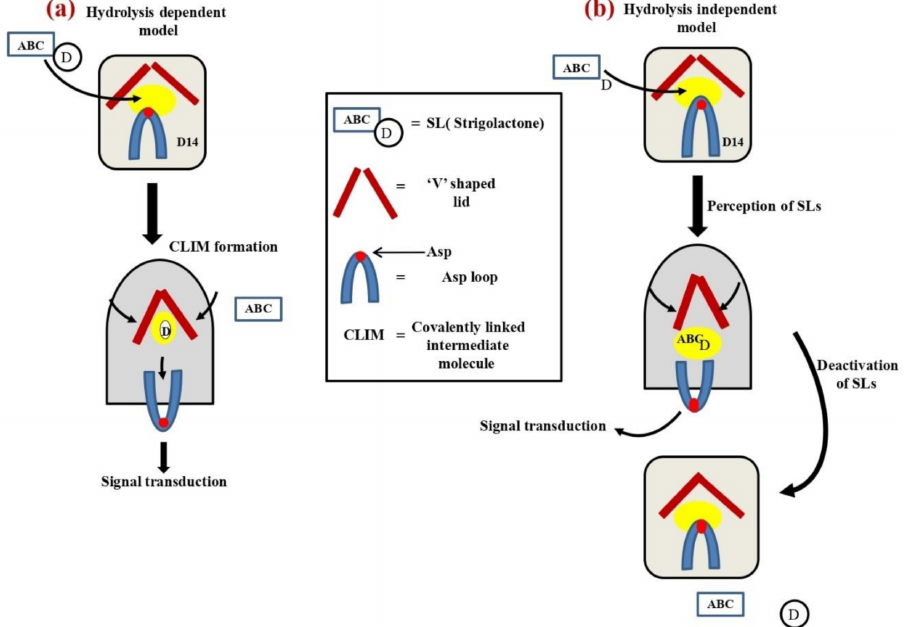
Figure 4. Two different models of SL perception showing the conformational change in D14. The figures are modified from Mashiguchi et al. [30]. ( a ) The hydrolysis intermediate derived from the D-ring part of SLs covalently linked with the receptor, D14, and resulted in a conformational change [52]. ( b ) The intact SL molecules cause a conformational change in D14, and D14 then returns to its catalytically active form